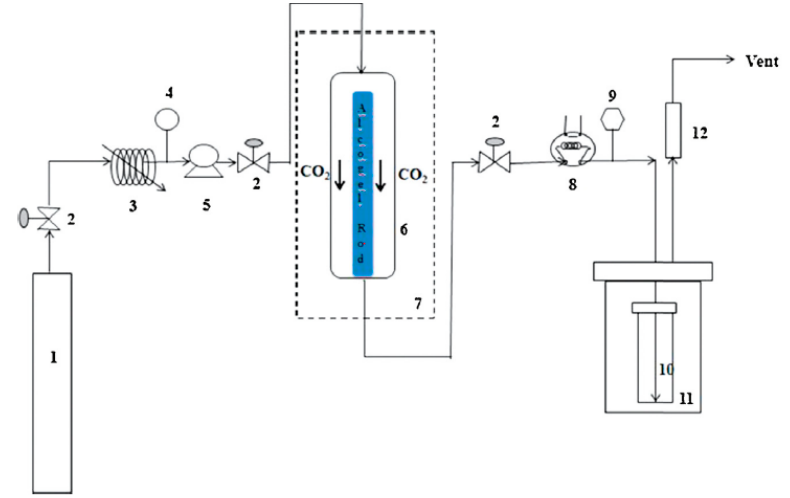
Figure 7. Schematic representation of process flow diagram of drying unit used in our studies (1. CO 2 tank, 2. Valve, 3. Cooler, 4. Pressure transducer, 5. Pump, 6. Tubular extraction vessel, 7. Oven, 8. Micro-metering Valve, 9. Thermocouple, 10. Sample collection vial, 11. Dry ice cooling bath, 12. Rotameter). Adopted with permission from [5].